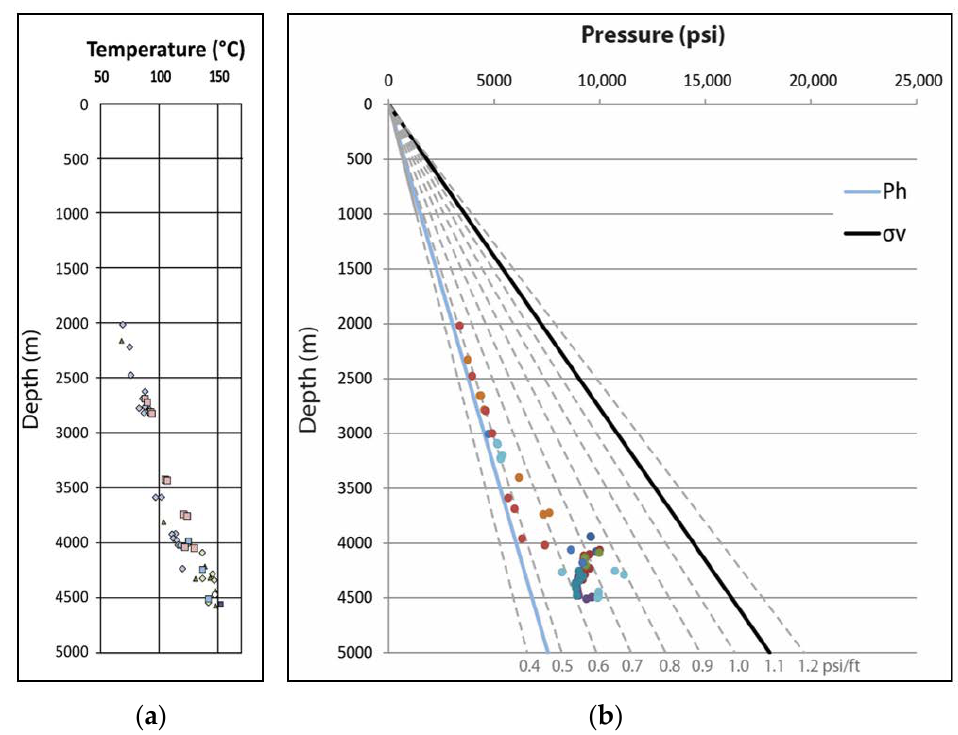
Figure 7. ( a ) Temperature gradient in some of the wells of the Abadan Plain Basin. The temperature gradient reaches its peak at the depth of the Gadvan Shale. ( b ) Direct pressure measurements in the Abadan Plain Basin, color-coded by